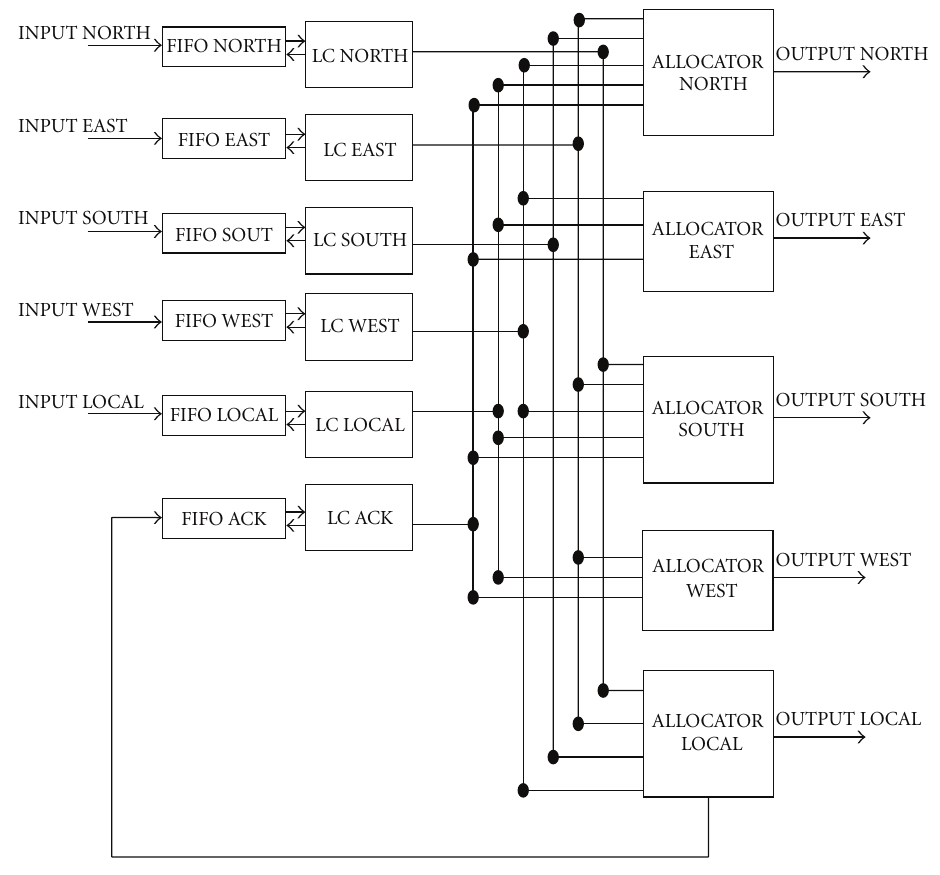
Figure 4: Packet-switched subrouter.